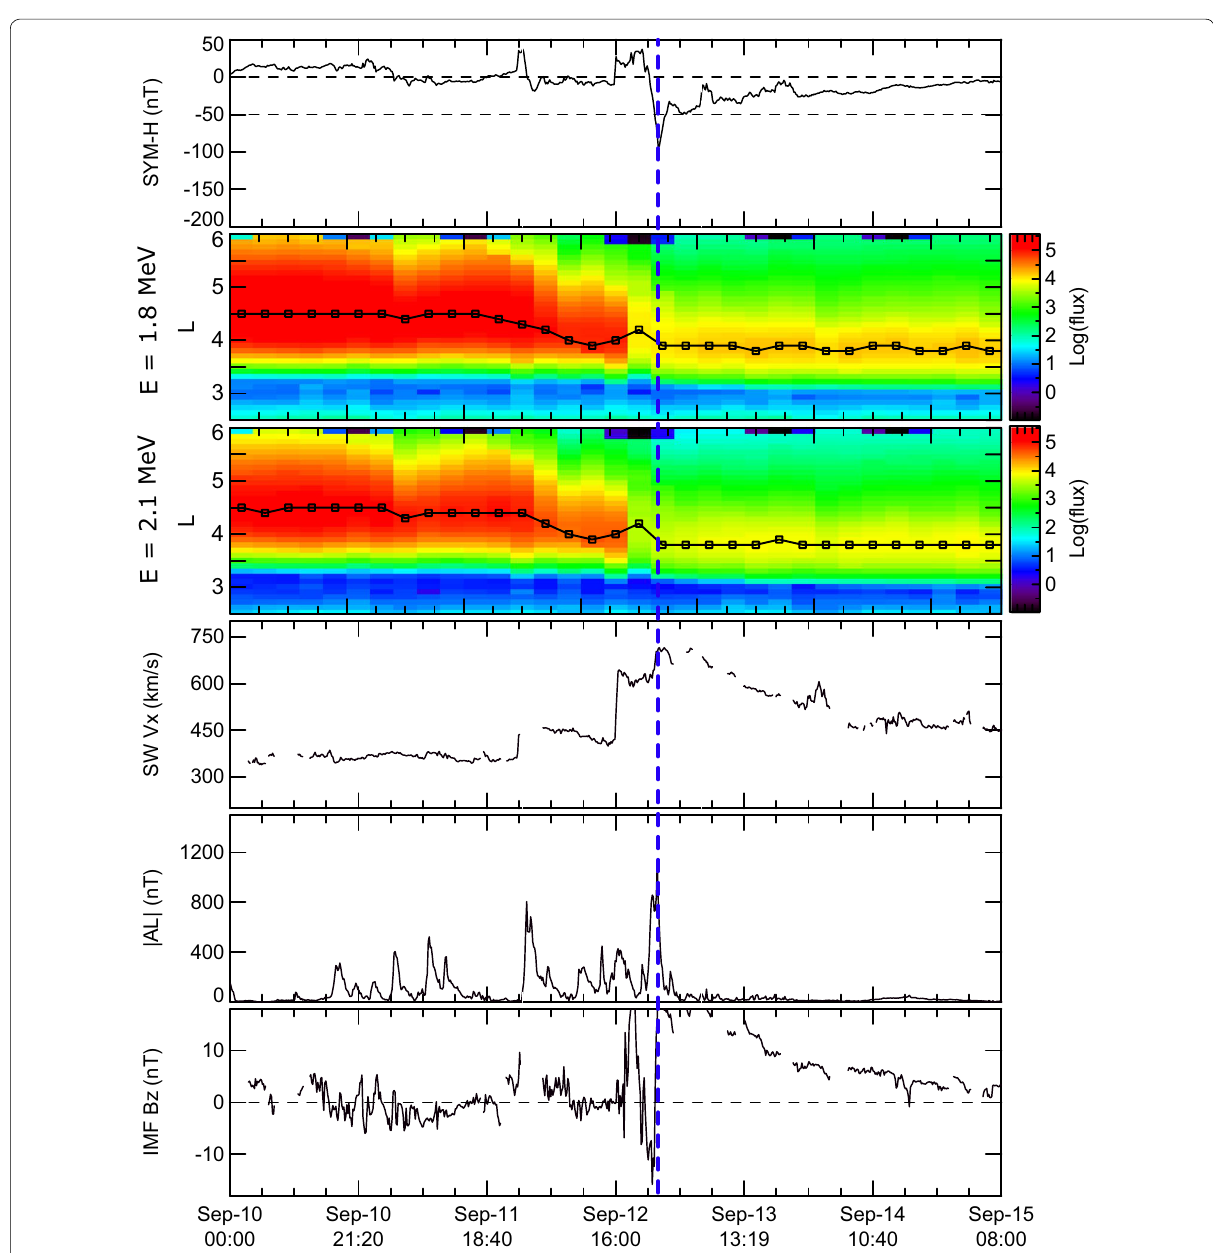
Fig. 2 The same as in Fig. 1 for the 12 September 2014 geomagnetic storm, when the decrease in ORB fluxes is